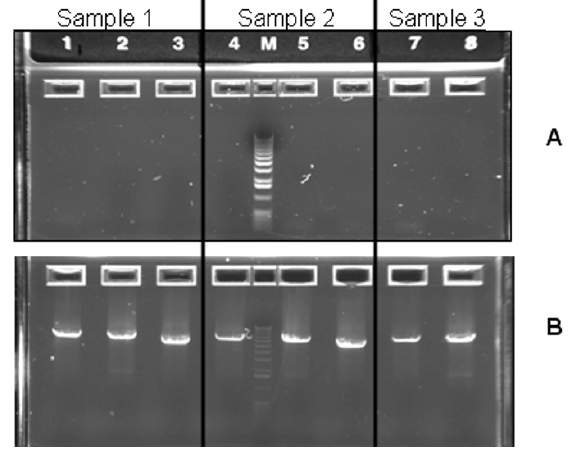
sample 3. For all three samples the PCR products are shown in the following order on the gel: 6185 bp product, 6015 bp product and 5063 bp